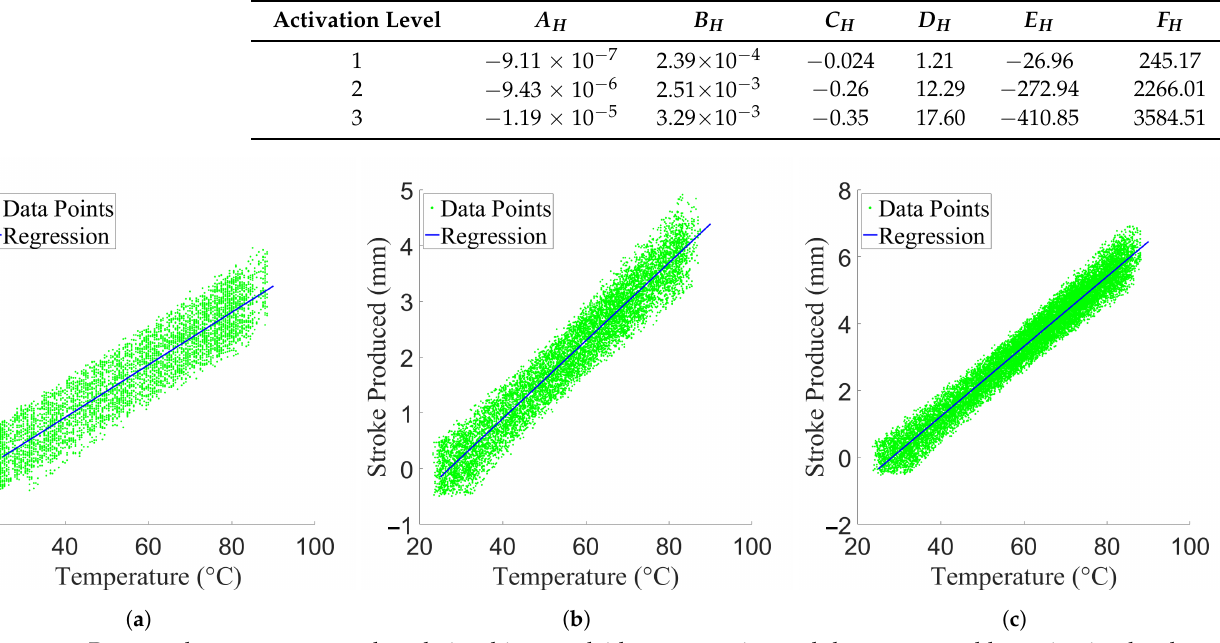
Table 2. Regressed temperature–force relationships, as described in Equation (3), by activation level.